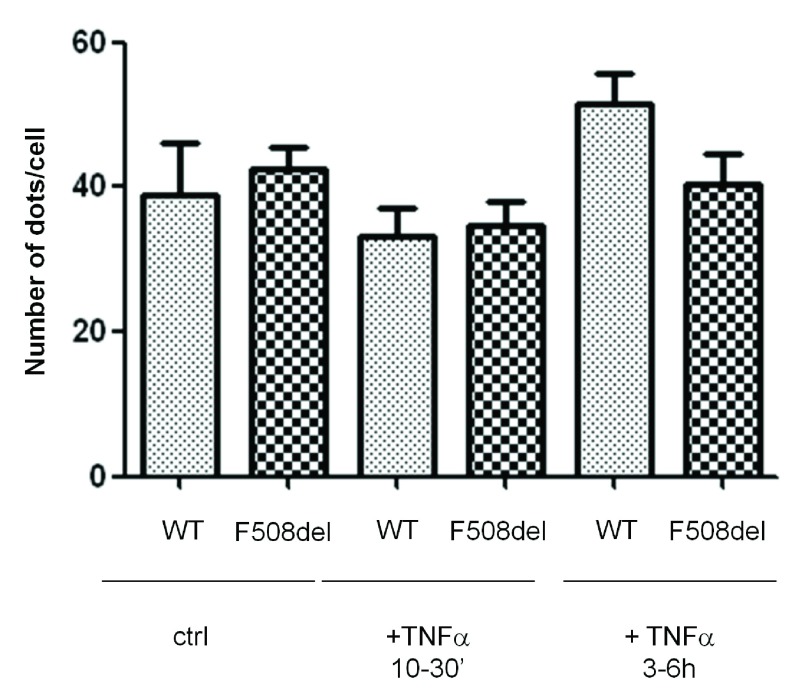
Effect of TNFα on F508del-CFTR-NHERF1 proximity in expressing F508del-CFTR HeLa cells.Number of pairs F508delCFTR-NHEFR1 in controls in TNFα-treated (as indicated) cells; Number of cells for control NHERF1-WTCFTR: 39 ± 13 n=90, NHERF1-F508del-CFTR: 42 ± 6, n= 80 cells; cells treated for 30min: NHERF1-WTCFTR 33 ± 7.7 n= 114 cells, NHERF1-F508del-CFTR 35 ± 7.1 n= 106; treated for 3 h: NHERF1-WTCFTR: 51 ± 9.1 n= 80 cells, NHERF1-F508del-CFTR: 40 ± 8.2 n=104 cells, p= NS in all conditions.